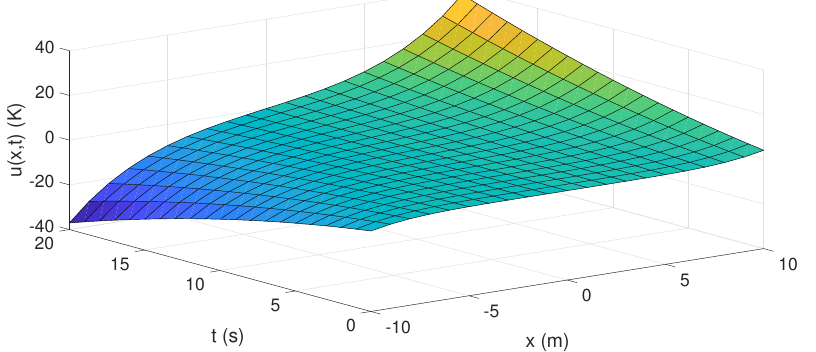
Figure 2. Scalar field resulting from Equation (14) with β 1 = 0.4 × 10 − 4 , β 2 = 0, β 3 = 0, and α = 1.2. The exponential scalar field of Equation (17) is also plotted (Figure 3). It can also be seen that the temperature increases with time. In particular, when positive constants are used, the temperature increases at the left end, i.e., at x = 0; however, this can be changed. When negative constants are used, the exponential solution becomes similar to the polynomial solution (Figure 4).